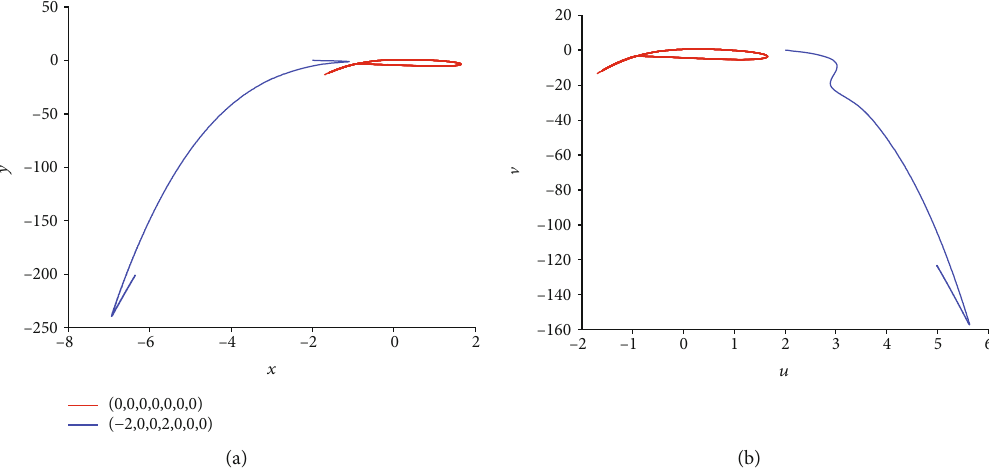
Figure 10: Coexistence of various fi ring patterns dependent on initial values in model (2) with k = 0 : 1 and I for initial value ð 0, 0, 0, 0, 0, 0, 0 Þ while the blue one is for initial value ð − 2, 0, 0, 2, 0, 0, 0 Þ